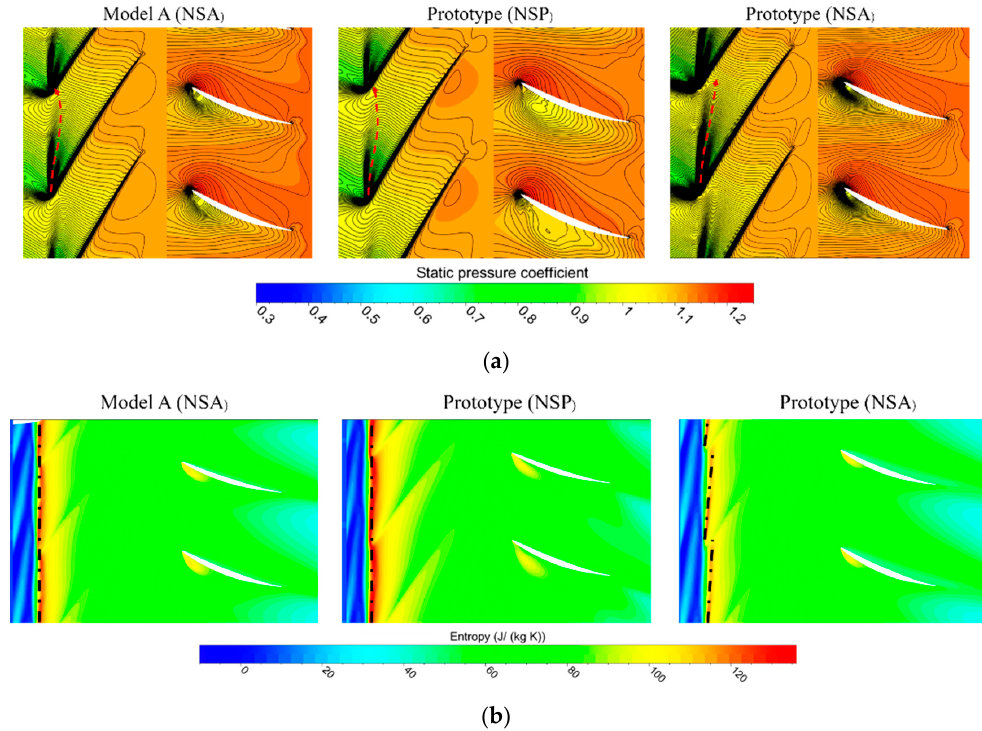
Figure 12. Comparisons of static pressure and entropy distributions at 99.5% spanwise: ( a ) static pressure distribution; ( b ) entropy distribution.